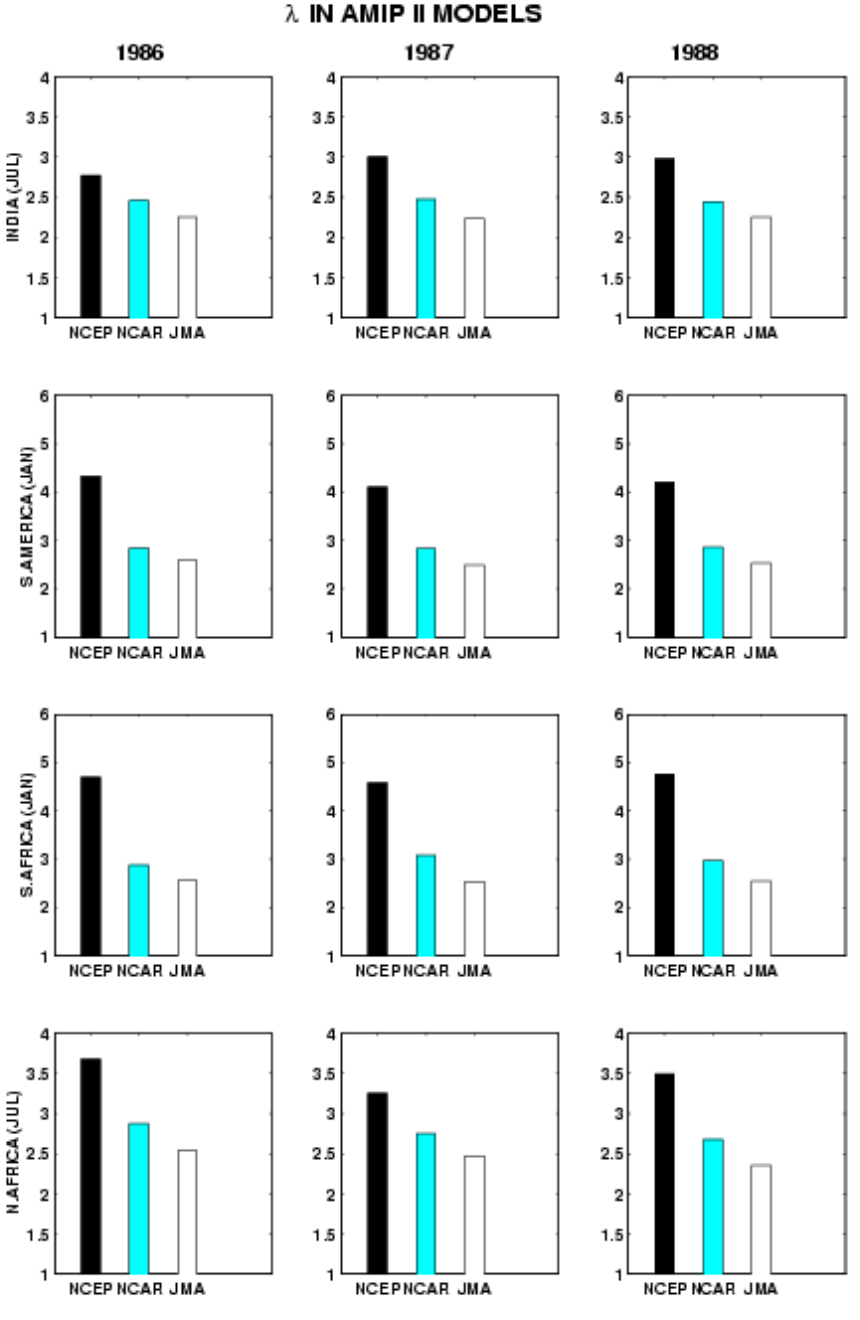
Fig. 8. Variation of non-dimensional water vapour scale height λ in different